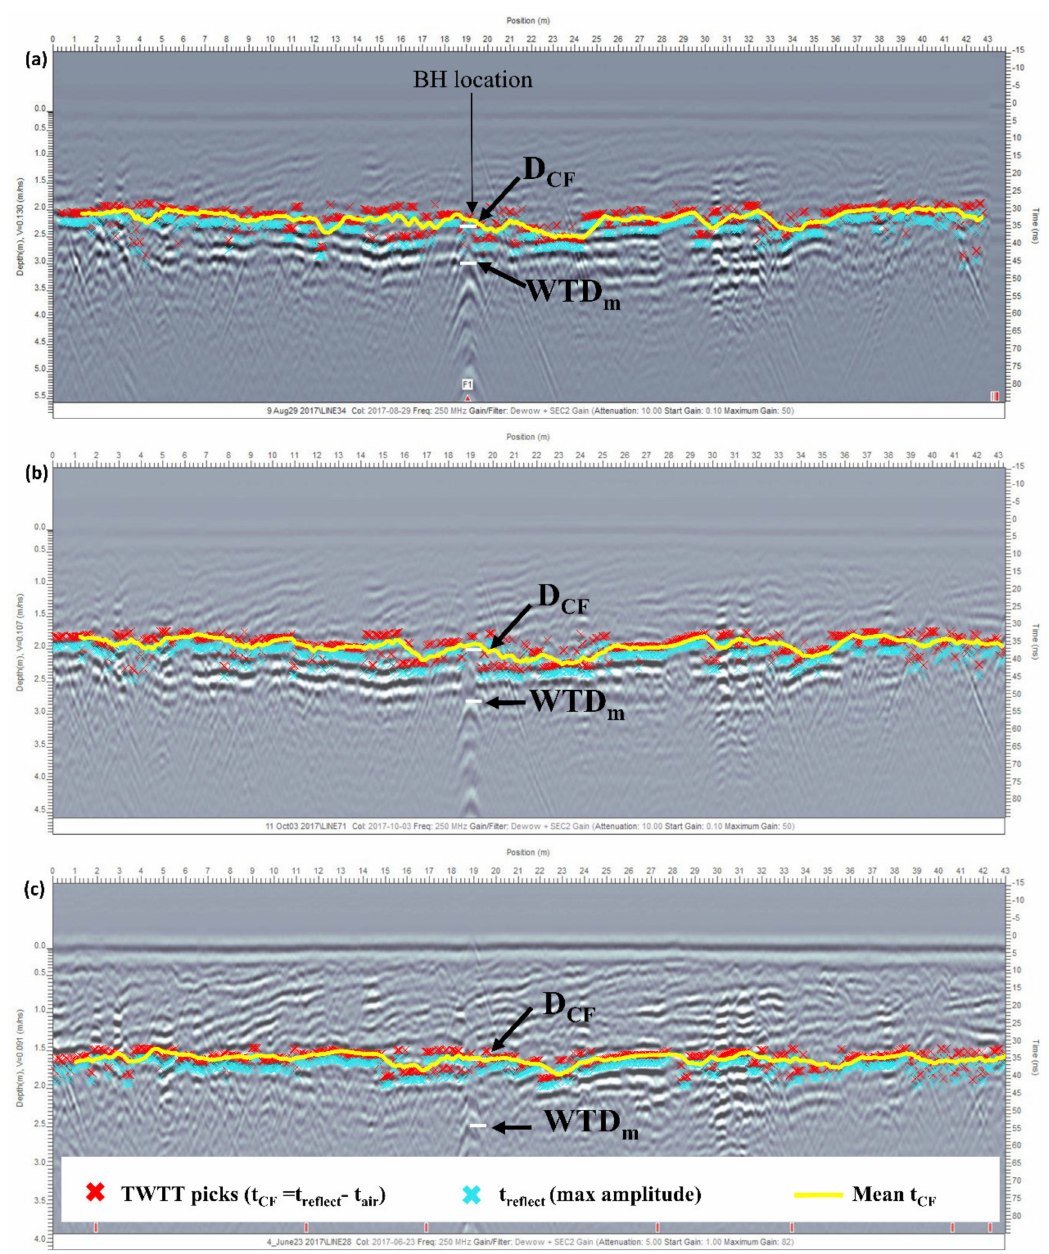
Figure 4. Two-way travel time (TWTT) picks of the maximum amplitude of the reflection (t reflect ), after time-correction (t CF ), and the mean t CF . Ground penetrating radar (GPR) estimated (250 MHz) depth to the capillary fringe (D CF ) and the measured water table depth (WTD m ) at the borehole (BH): ( a ) under wet soil moisture conditions on 23 June, ( b ) under median soil moisture conditions on 3 October and ( c ) under dry soil moisture conditions on 29 August in the growing season of